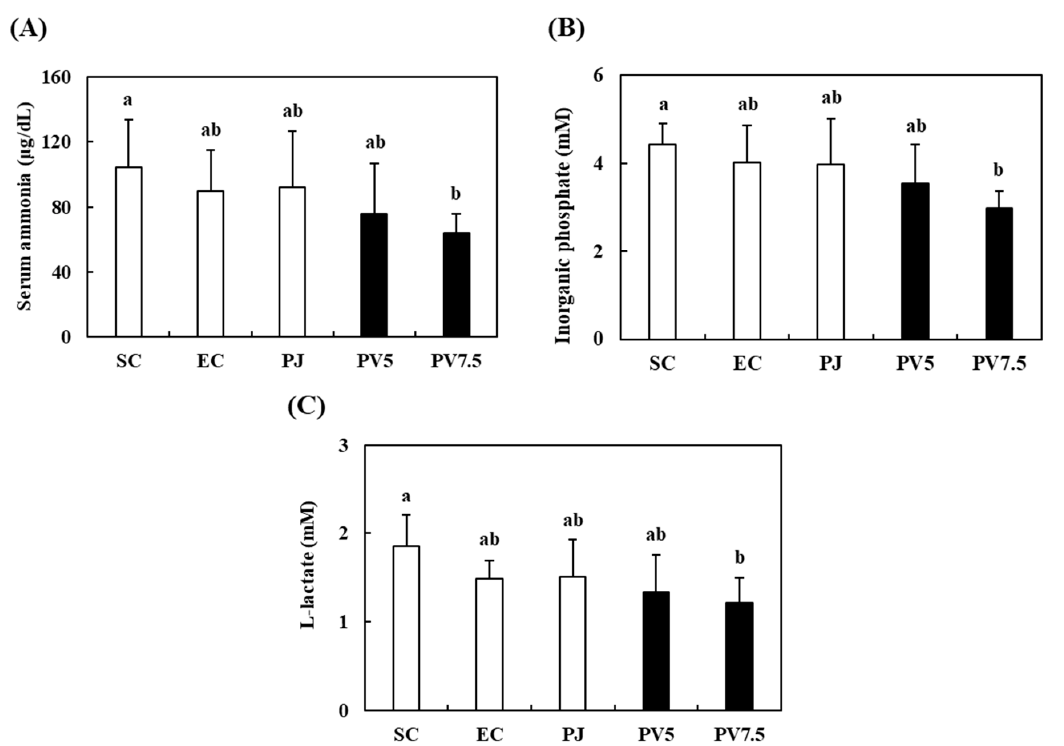
Figure 4. Effect of PV on serum (A) ammonia, (B) inorganic phosphorus, and (C) lactate in exhausted rats. Data values are expressed as the means ± S.E. ( n = 6). SC: sedentary control, EC: exercised control,